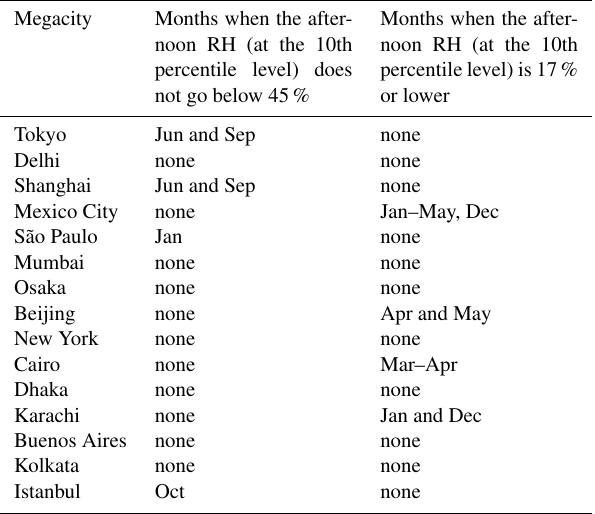
Table 3. Months when the afternoon RH in the 15 most populous megacities either does not go below 45% (at the 10th percentile level) or is 17% or lower (at the 10th percentile level) and the median afternoon temperature is 290–300K. “None” indicates that these criteria are not met for any month.